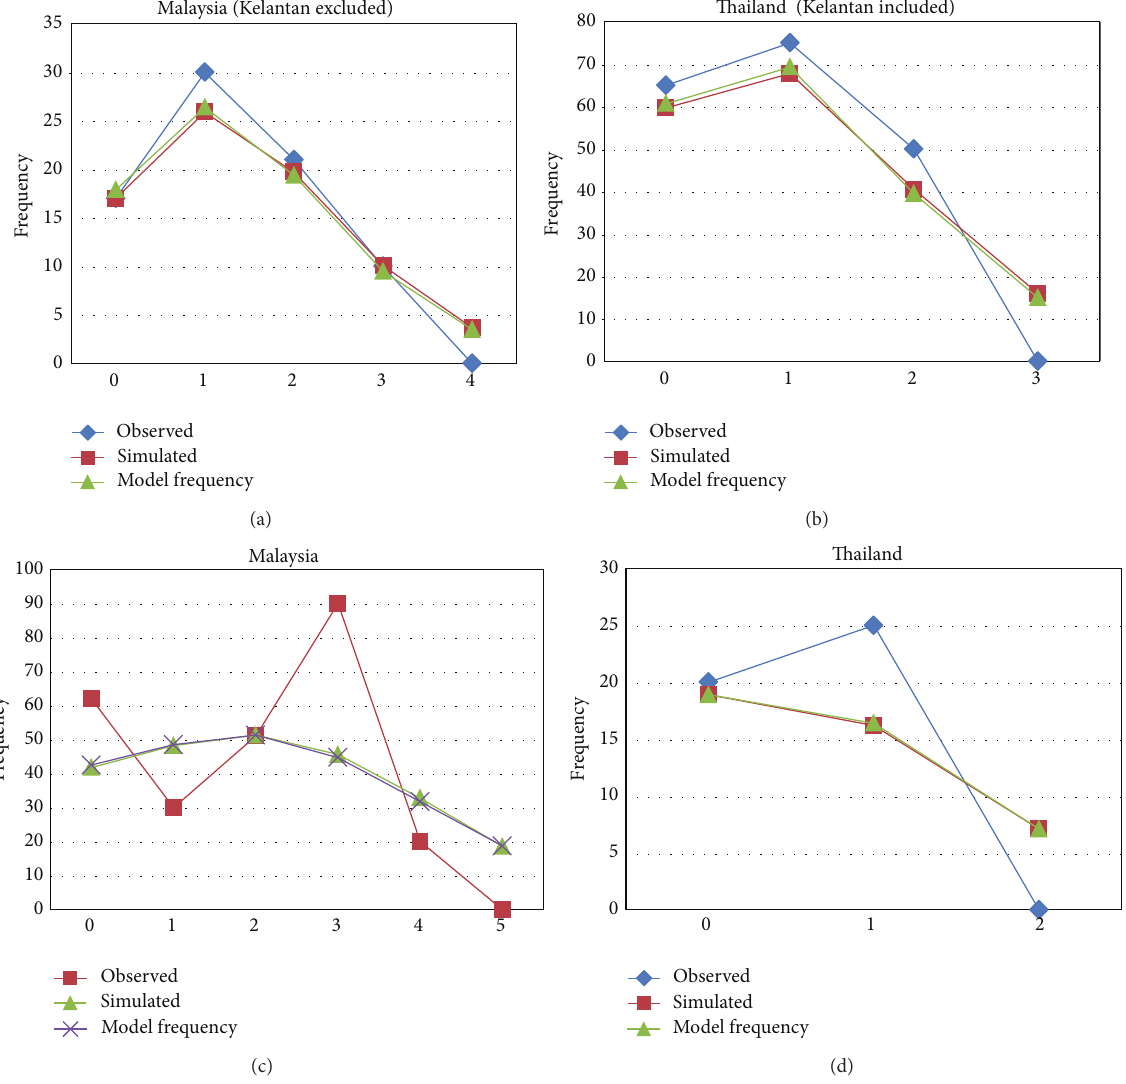
Figure 6: Mismatch distribution of the observed frequencies of pairwise differences among D-loop sequences and expected frequencies under the sudden and spatial expansion models, including and excluding Kelantan population for each